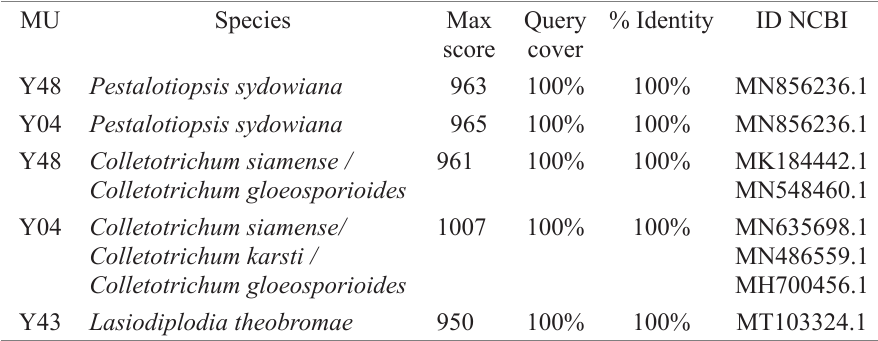
Table 2. Results of molecular ID of the isolates (from the plant samples with symptoms of leaf spots and regressive death) compared with the